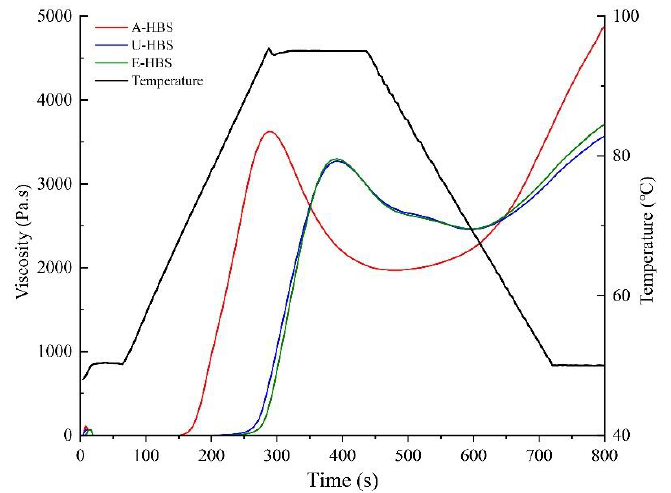
Figure 3. Pasting profiles of highland barley starch samples. A-HBS: HBS extracted by alkali method; U-HBS: HBS extracted by ultrasonic method; E-HBS: HBS extracted by enzymatic method. Table 2. Pasting and textural properties of highland barley starch samples.